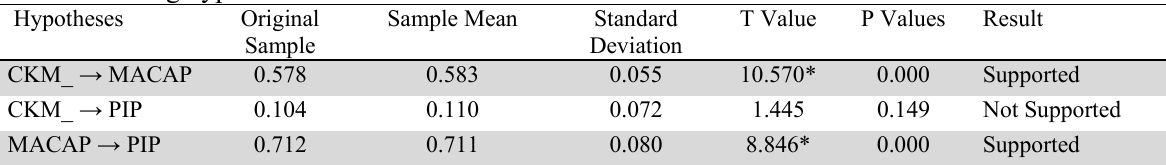
Result of testing hypotheses